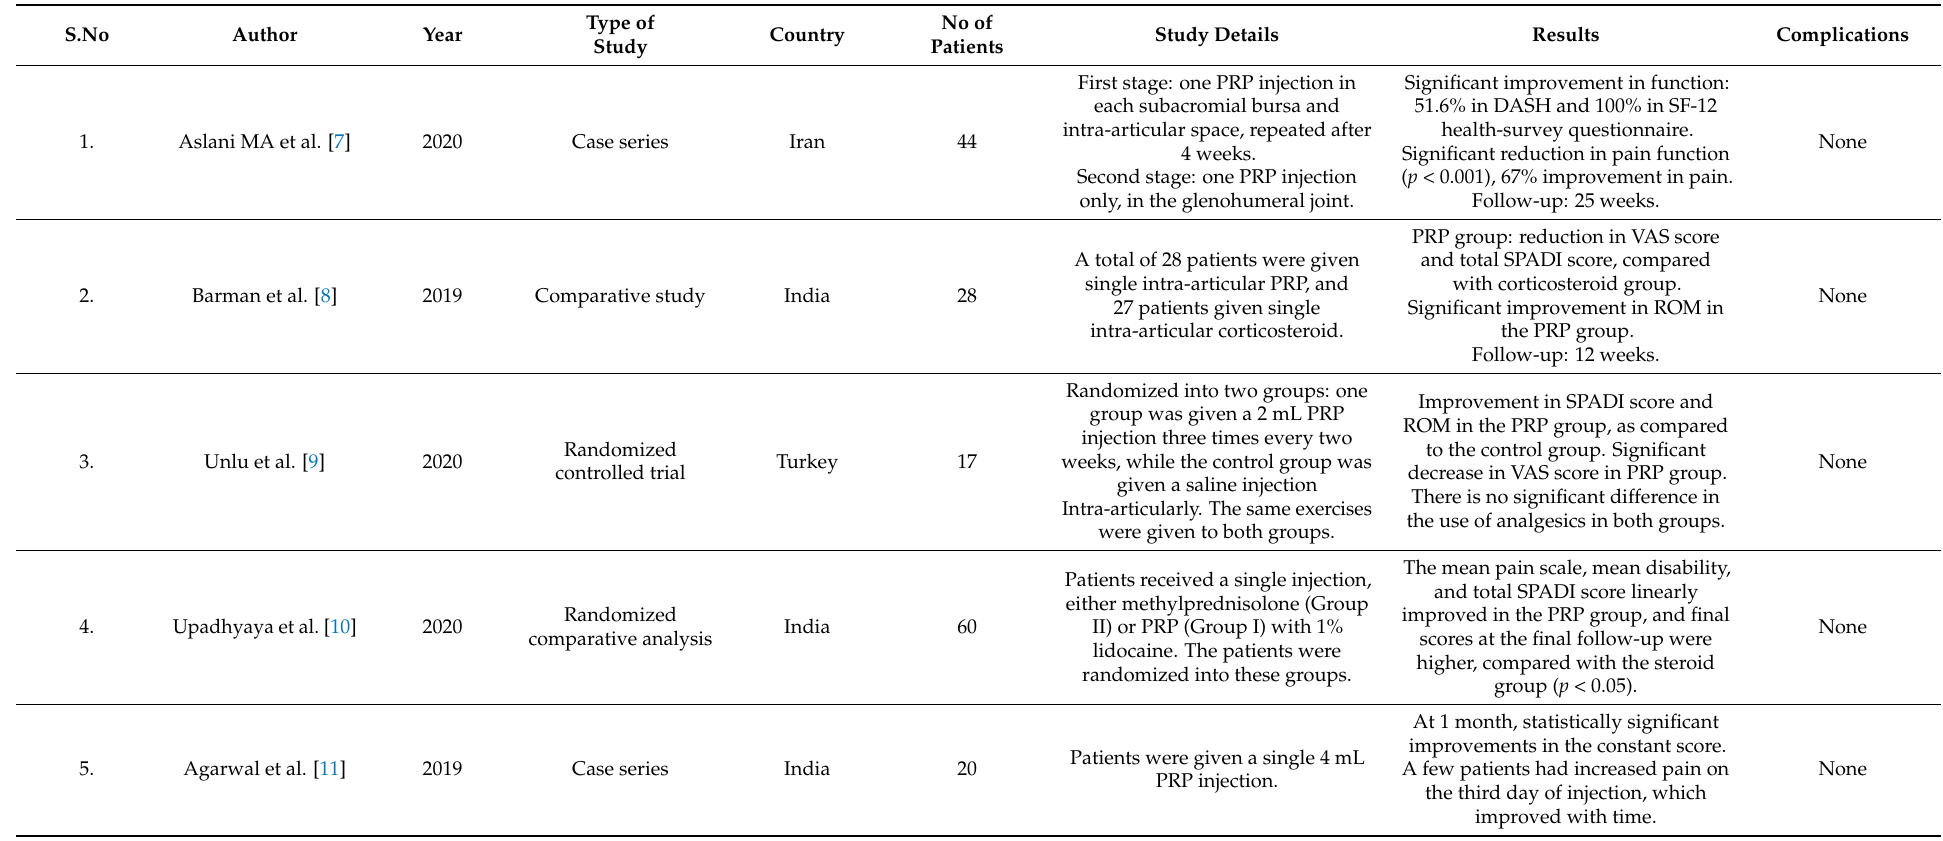
Table 1. Describing the details of various